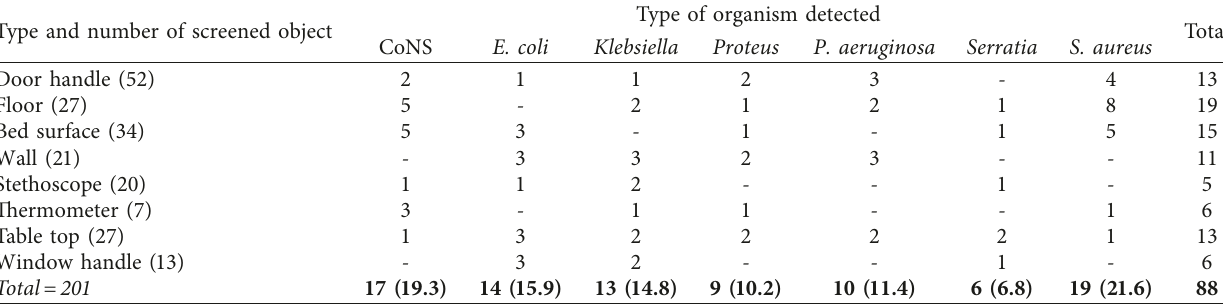
Table top (27) -, no detection of specified organism in that particular object. Table 3: Antimicrobial susceptibility pattern of nosocomial bacteria isolated at Mizan-Tepi University Teaching Hospital, 2017. Antimicrobials and their effect on bacterial isolates Bacterial isolate